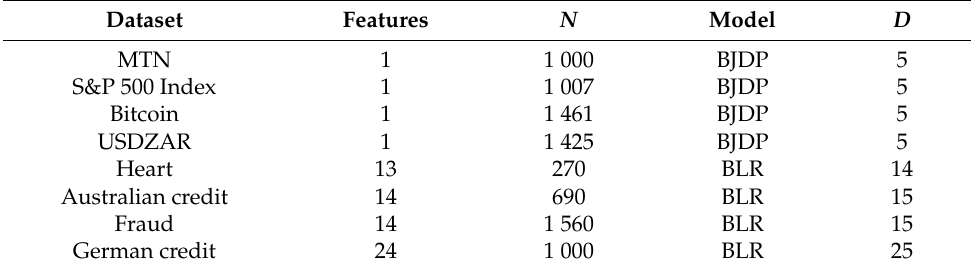
Table 1. This table shows the financial and benchmark datasets used. BJDP is Bayesian jump diffusion process. N is the number of observations. BLR stands for Bayesian Logistic Regression. D is the number of model